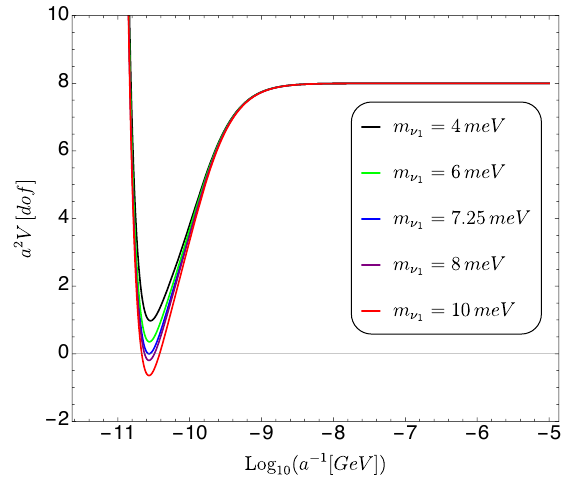
Figure 7 . Zoom in of (cid:12)gure 6 around the neutrino scale. We always assume Dirac neutrinos, since Majorana neutrinos are ruled out. Using experimental constraints on the neutrino masses, we choose as free parameter the mass of the lightest neutrino. If its mass is larger than 7 : 25 meV, an AdS minima develops.